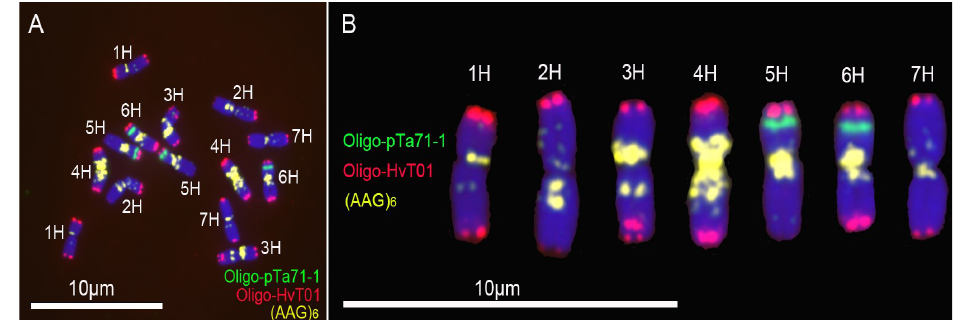
Figure 1. Non-denaturing in situ fluorescence hybridization (ND-FISH) analysis of root tip metaphase chromosomes of barley cultivar CNSimai 1: ( A ) Oligo-pTa71-1 ( green ), Oligo-HvT01 ( red ) and (AAG) 6 ( yellow ) were used as probes; and ( B ) Karyotype of barley cultivar CNSimai 1. Chromosomes were counterstained with 4',6-diamidino-2-phenylindole (DAPI) ( blue ). Scale bar: 10 μm.